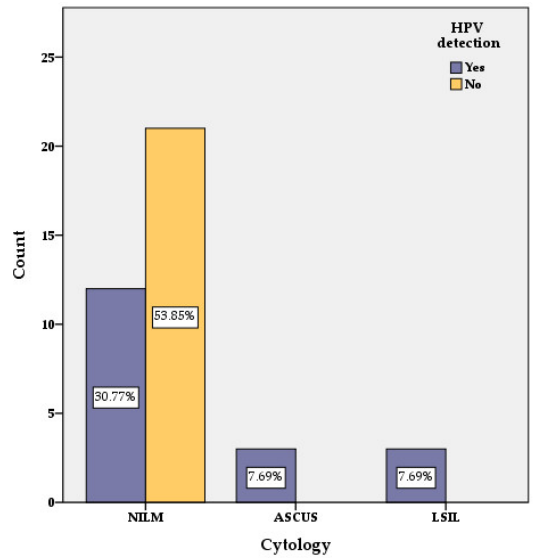
Figure 2. HPV distribution regarding cytology findings.